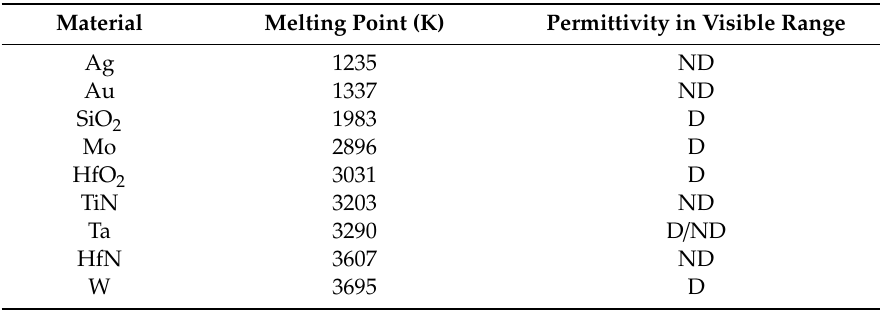
1 ND: Negative Dielectric; D: Dielectric.